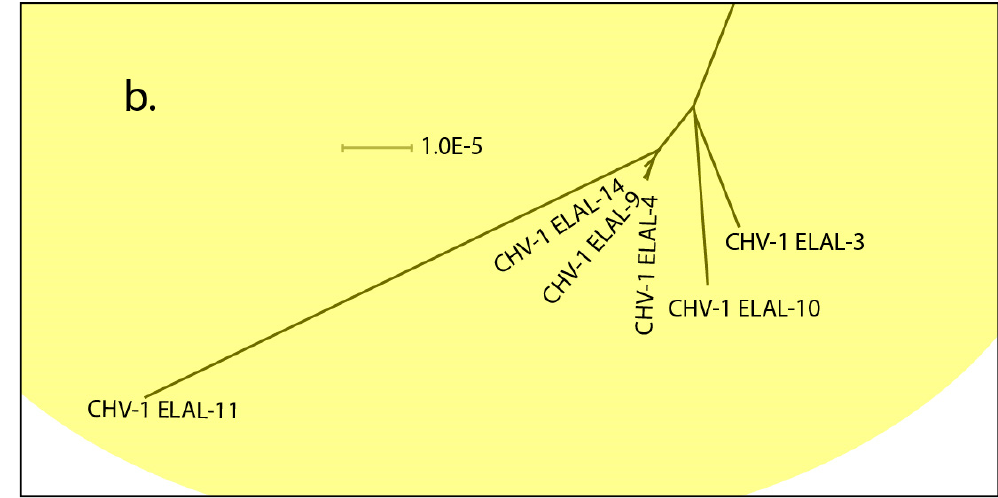
Figure 2. ( a ) Phylogenetic network of all analyzed CHV-1 isolates with a FHV-1 (C-27) outgroup. Two distinct clades are visible: 1 (yellow) and 2 (blue). The interclade distance (0.14%) is illustrated with a red line and was calculated using an alignment of consensus sequences (MAFFT ver. 7.450) from each clade. The mean intraclade distances were calculated using MEGAX. ( b ) Detail of subsection of clade 1 from Figure 2a. All isolates shown in this subsection were obtained from the same outbreak of CHV-1 in New York State in 2008. As expected, the genomes of these particular CHV-1 isolates are extremely homogenous.